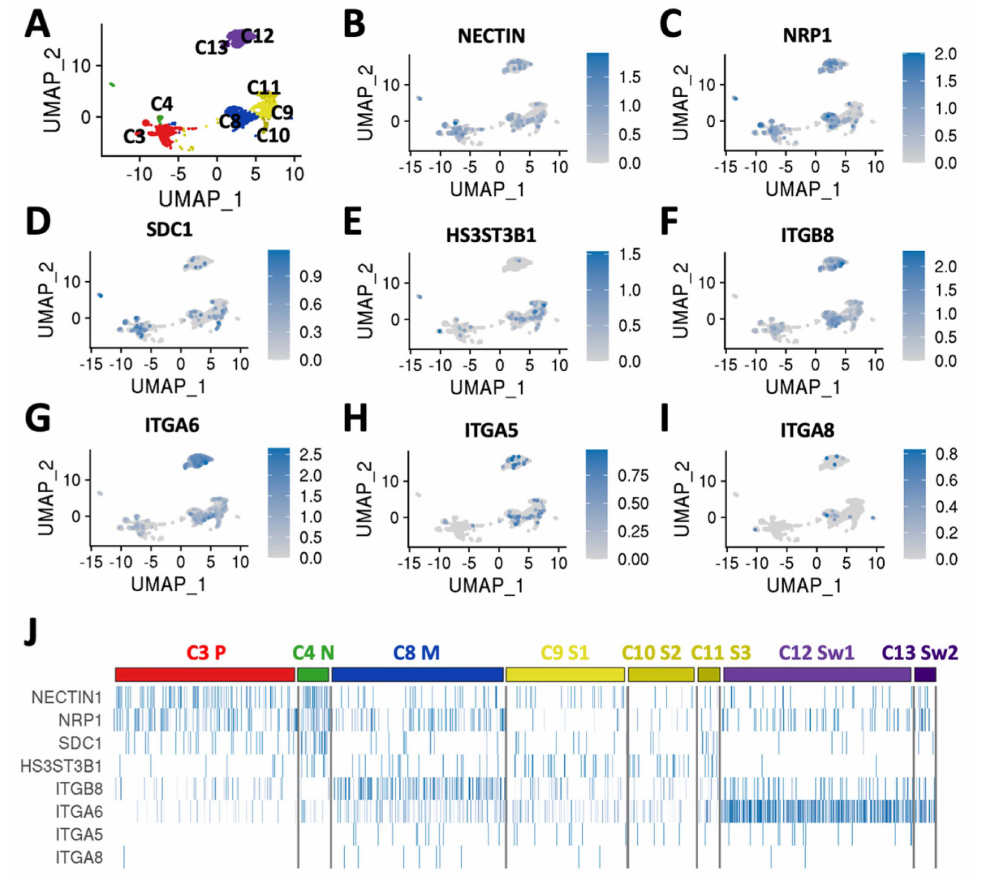
Figure 3. Single-cell transcriptional profile of HSV receptors in DRGO. ( A ) Uniform Manifold Approximation and Projection (UMAP) plot displaying multidimensional reduction and